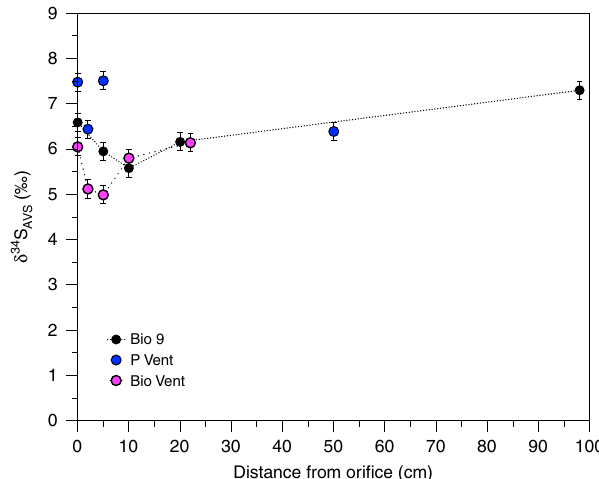
Fig. 2 Sulphur isotopic composition of AVS and CRS in the buoyant plume. Paired δ 34 S AVS and δ 34 S CRS values from plume samples showing the expected values based upon isotopic equlibration between FeS – H 2 S and pyrite – H 2 S (the experimental equilibrium values were taken from Syverson et al. 24 and were determined for T = 350 °C. We note that it is not certain what the isotope fractionation is at lower temperatures). Note that CRS values are not available for all AVS samples from Fig. 2 due to small sample size. Labels next to the data points represent the in situ temperature (°C) at which the samples were